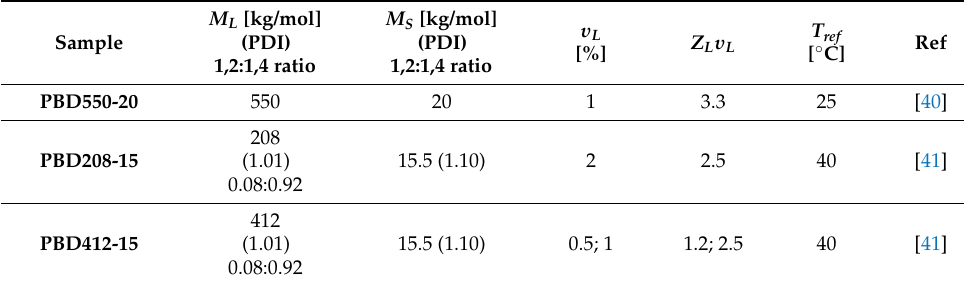
Table 5. Bidisperse PBD samples.